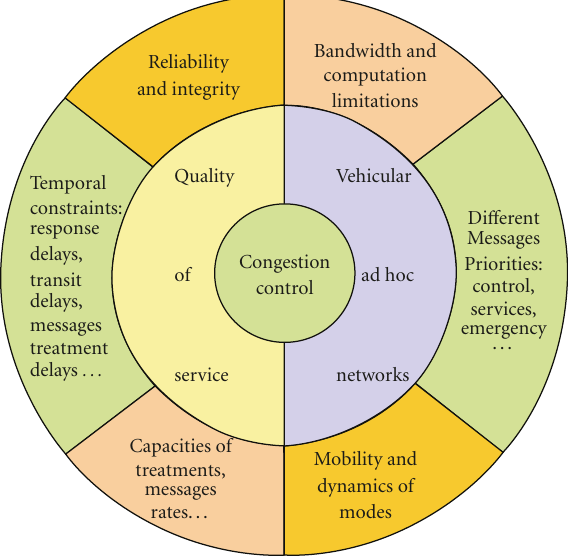
Figure 2: Congestion Control Context within